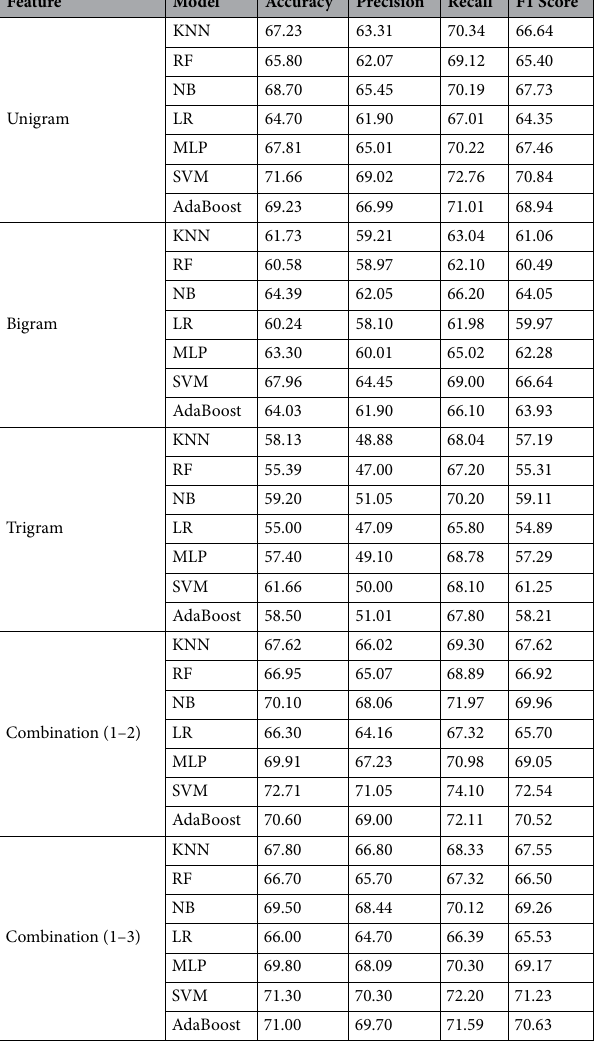
Table 6. Urdu sentiment analysis results using machine learning models with word n -gram